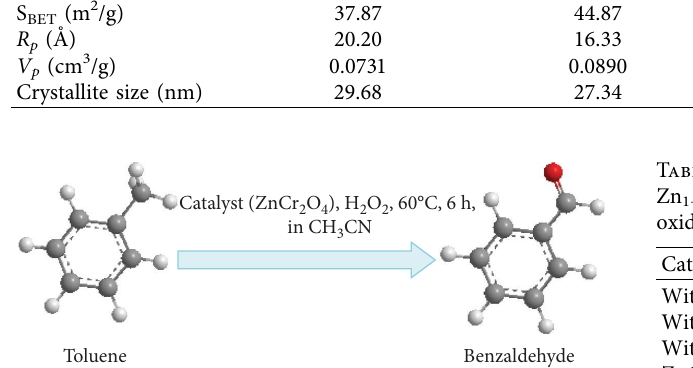
Figure 3: HR-TEM images of (a, b) pristine ZnCr Table 1: BETsurface area, average pore diameter, pore volume, and their crystallite size (nm) of pristine and Mn-doped ZnCr Catalyst properties